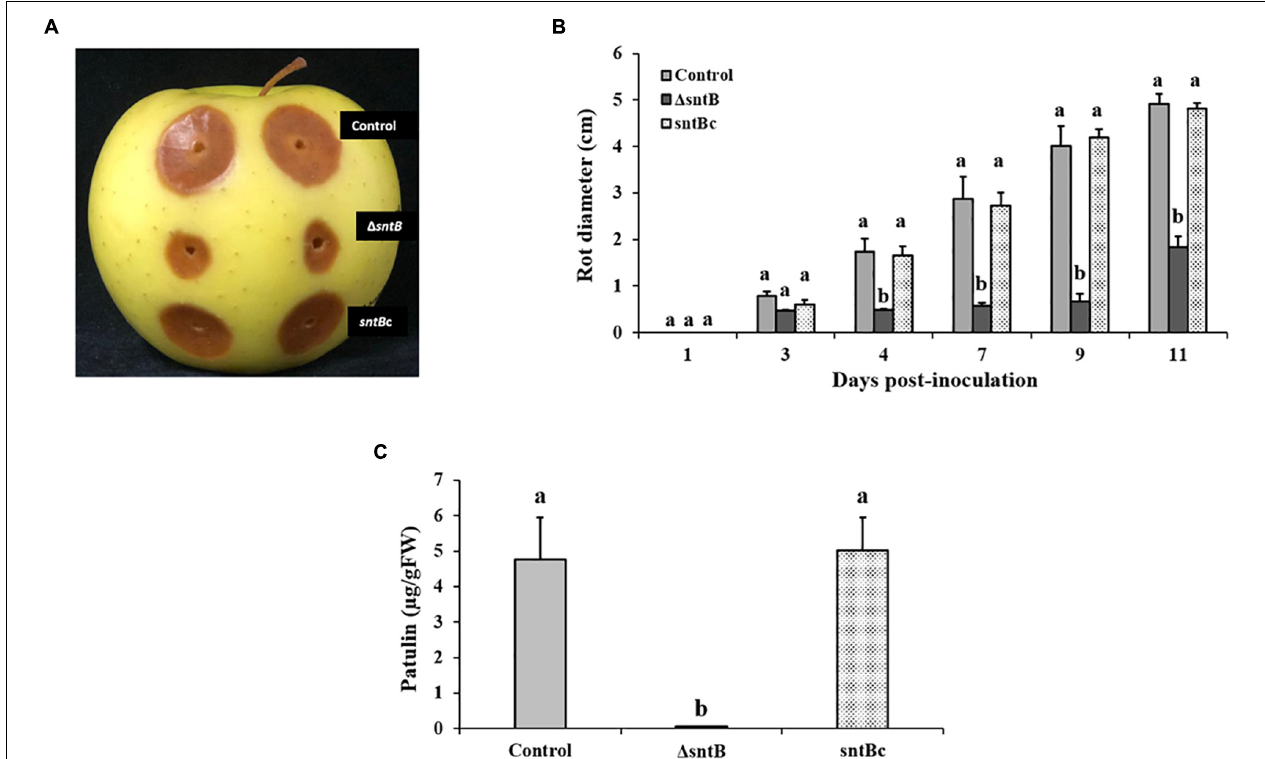
FIGURE 3 | SntB is required for P. expansum pathogenicity and patulin production on apples. (A) Apples were inoculated with 10 6 spores and incubated at 25 ◦ C in the dark for 5 days. (B) Histogram showing the rot diameter on apples inoculated with the three Penicillium strains (control, (cid:49) sntB , sntB c). (C) Histogram displaying patulin production on apples analyzed by HPLC. Each strain was inoculated with 3 reps. One-way ANOVA differences were considered significant when p < 0.05. Different letters above the columns indicate statistically significant differences between the strains as determined using Tukey’s single-step multiple comparison